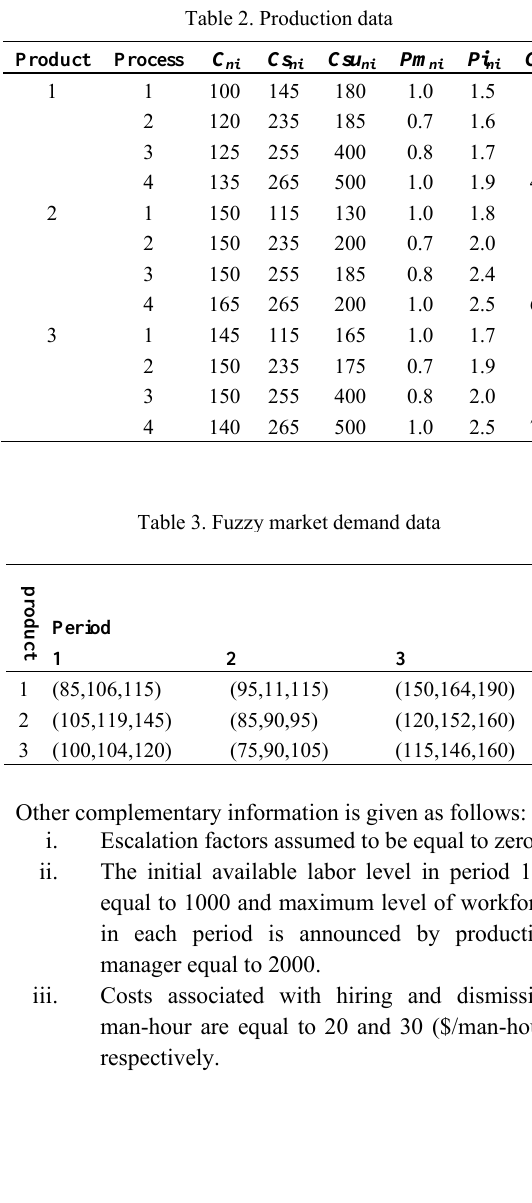
Table 4. Fuzzy machine capacity